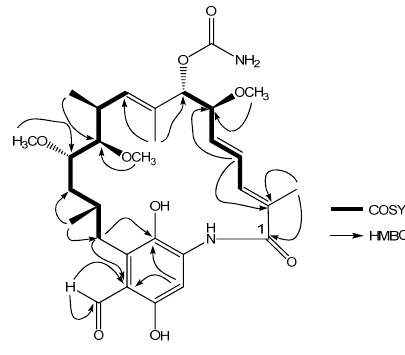
Figure 2. COSY and HMBC of compound 1 .